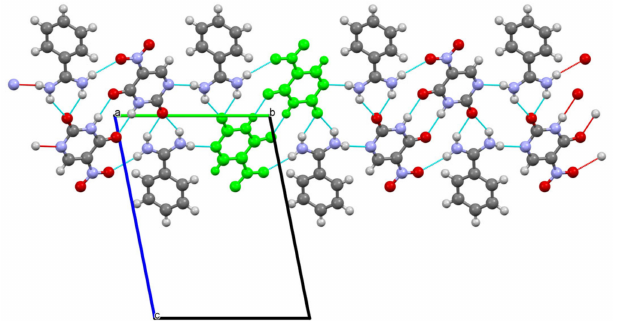
Figure 27. Detail of one of the ribbons of (XXIII) viewed along the a axis. One of the 5-nitrouracilate dimers is highlighted in solid